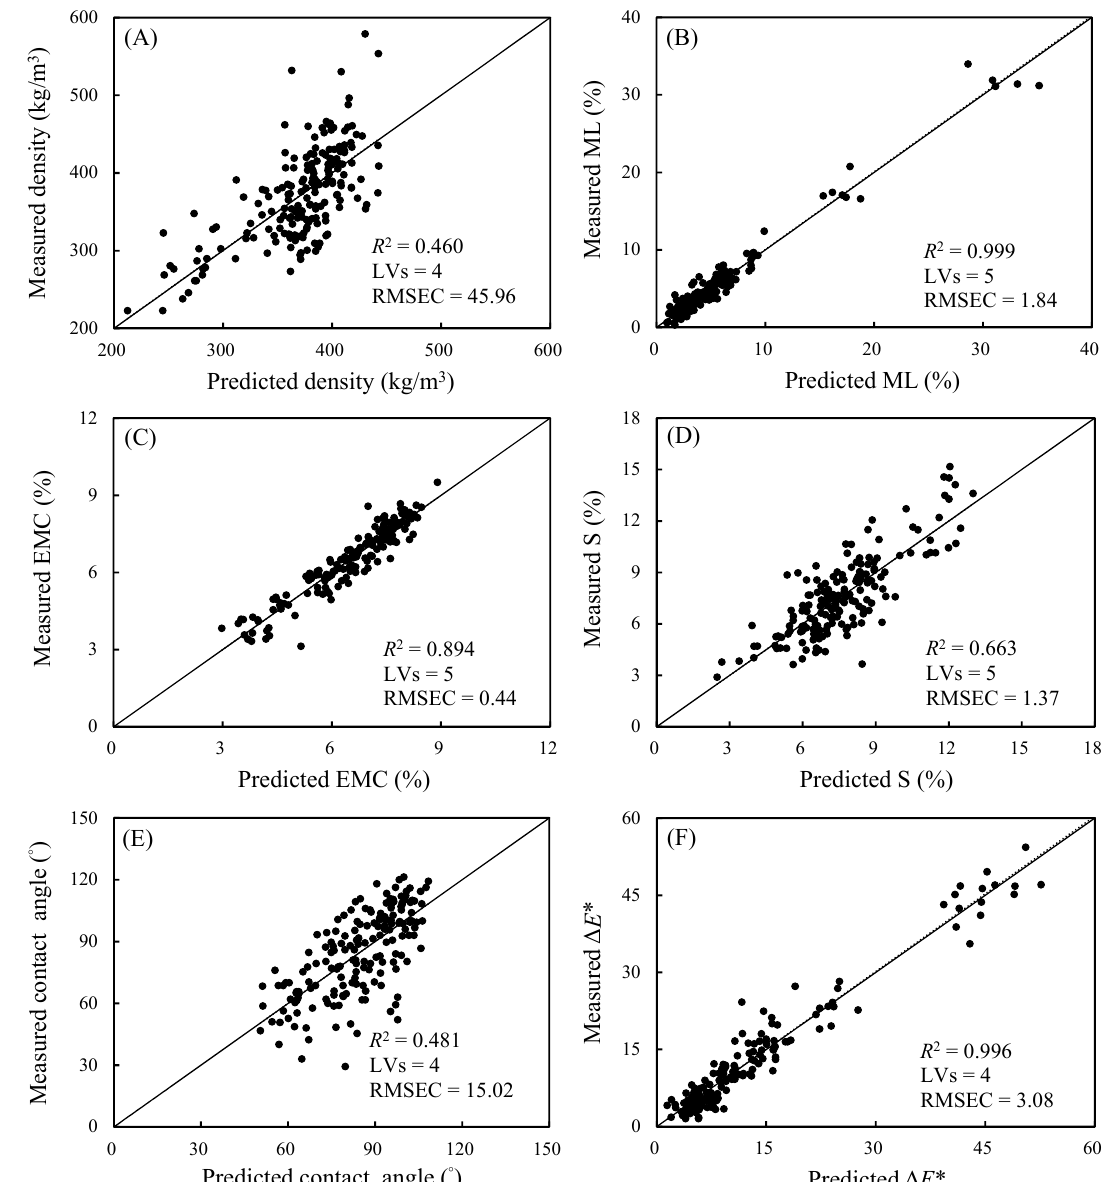
Figure 5. The correlation between predicted and measured values of air-dry density ( A ), ML ( B ), EMC ( C ), S ( D ), contact angle ( E ), and Δ E * ( F ) in calibration data.